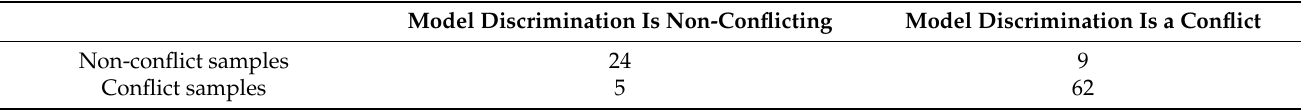
Table 11. Conflict indicator results based on the improved TDTC metrics.